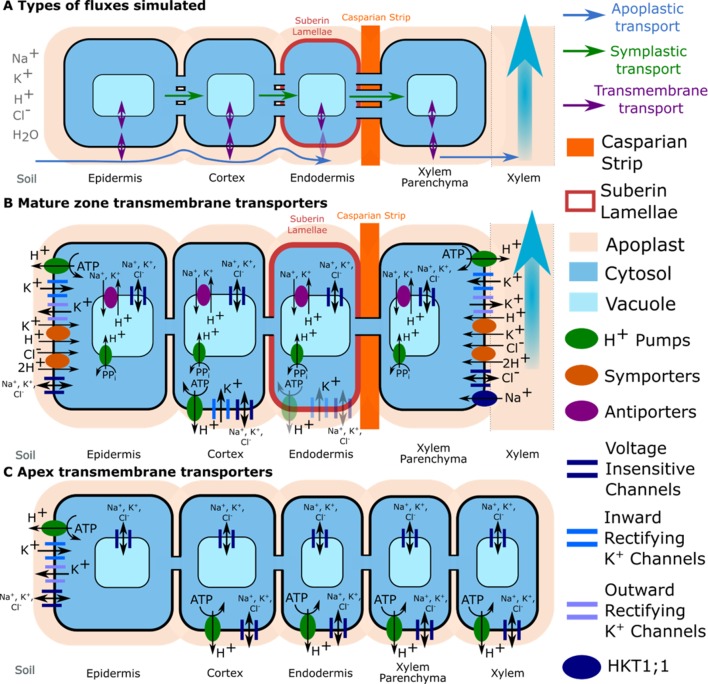
Transport pathways and membrane transport proteins included in the model. (A) Close-up of a single layer of cells in the mature zone highlighting the different transport pathways simulated for both ions and water (apoplastic, symplastic, and transmembrane). Axial symplastic and apoplastic fluxes are also simulated; although for visual clarity, they are not included in the figure. (B) Location of transporter and channel activity in the mature root. (C) Location of transporter and channel activity in the apex. The distribution of K+ voltage–dependent channels and K+/H+ symporters were obtained from the literature: Arabidopsis eFP Browser, Lagarde et al. (1996), Gaymard et al. (1998), Ivashikina et al. (2001), Desbrosses et al. (2003), and Gierth et al. (2005). Tonoplast Na+/H+ antiporters were assumed to be present in all cells in the mature zone, but not the apex (Shi et al., 2002). Trans-plasma membrane transport in the mature endodermis was assumed to occur only in cells lacking suberin lamellae (e.g., passage cells). Plasma membrane Na+/H+ antiporters are not shown because a wide range of spatial distributions were considered (see the section Investigating Possible SOS1 Location and Resulting Function). Arrows indicate the typical direction of transport identified during the model simulation.